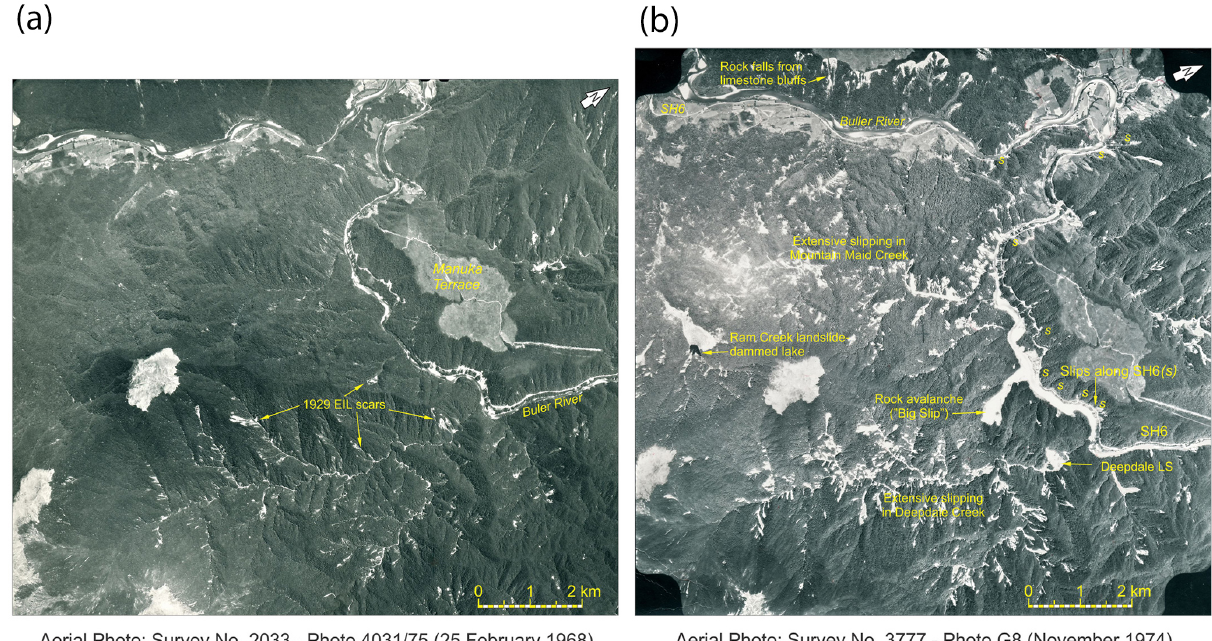
Figure 7. Two aerial images used to map landslides triggered by the 1929 and 1968 earthquakes in the Buller Gorge area. Scars from the 1929 landslides are recognisable on the Survey No. 2033 image (a) , 39 years after the earthquake, and many scars were reactivated or enlarged by the 1968 earthquake (b) .